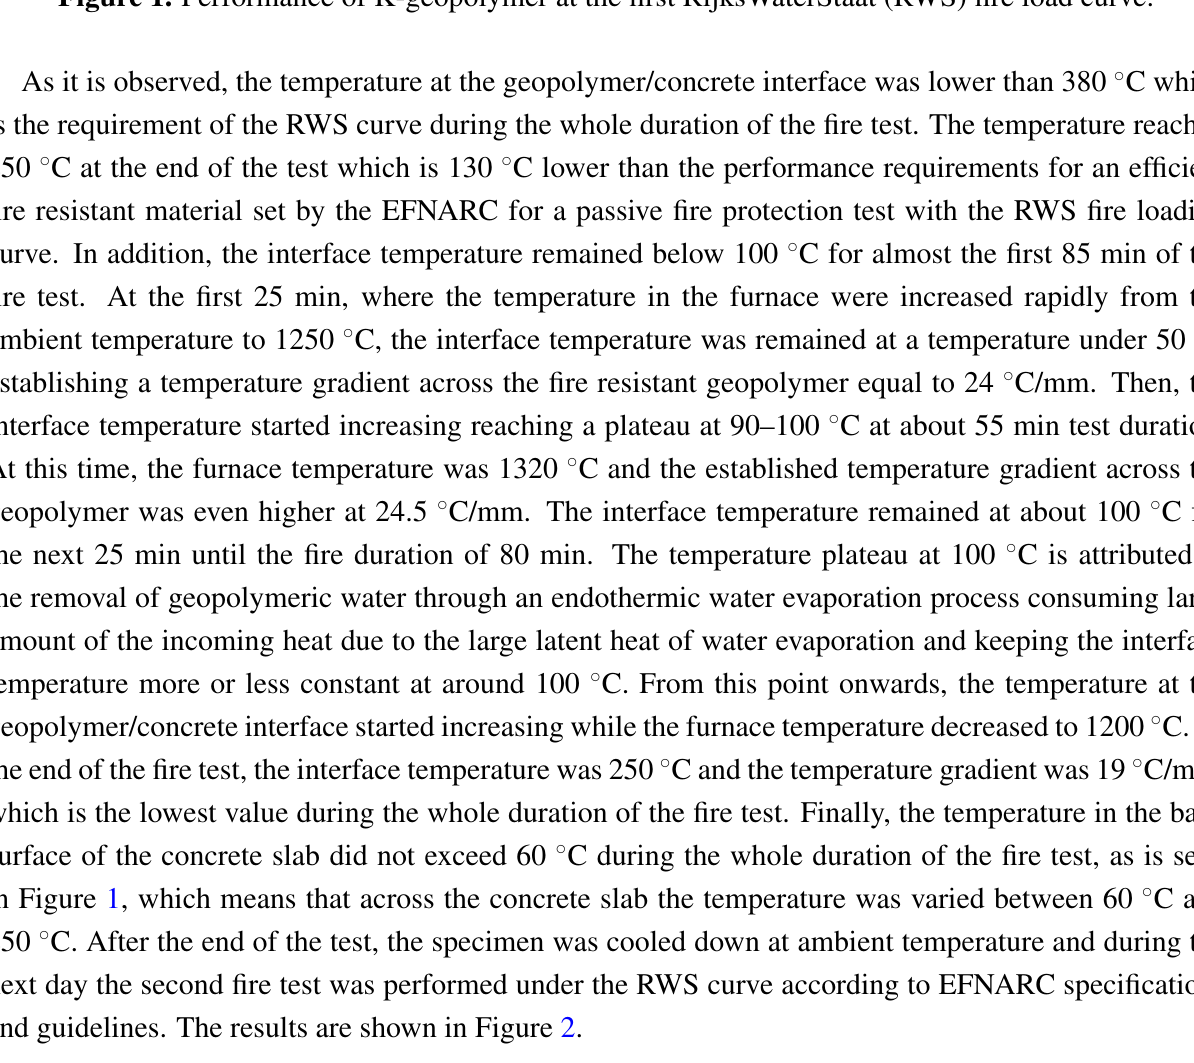
Figure 1. Performance of K-geopolymer at the first RijksWaterStaat (RWS) fire load